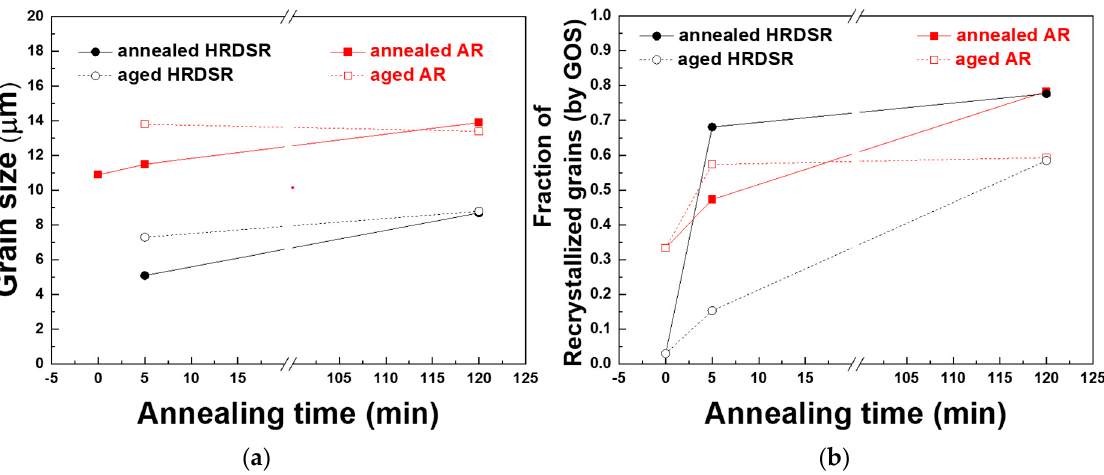
Figure 4. ( a ) The grain size of the AR and HRDSR samples before and after heat treatment. ( b ) The fraction of recrystallized grains in the AR and HRDSR samples before and after heat treatment determined using GOS.